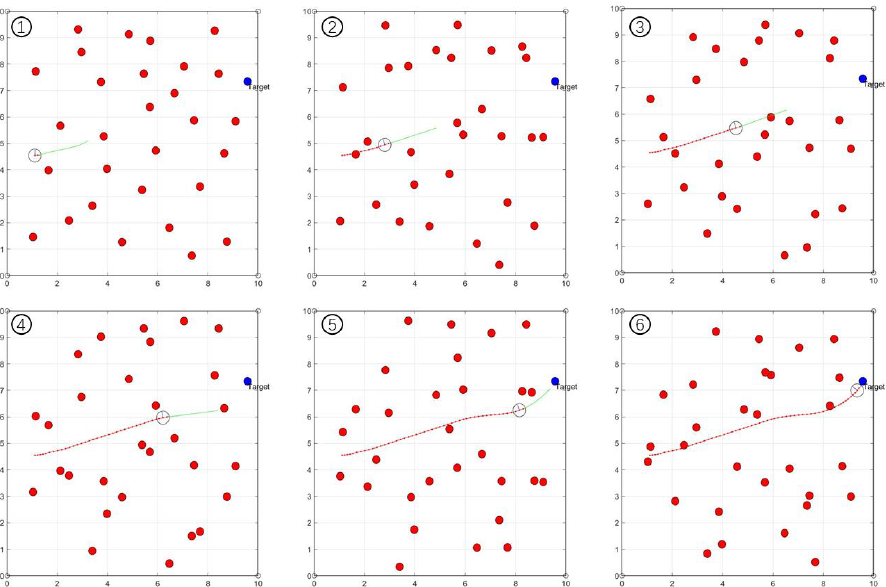
Figure 18. CPU time comparison of APOLLO, TEB and FALCO.